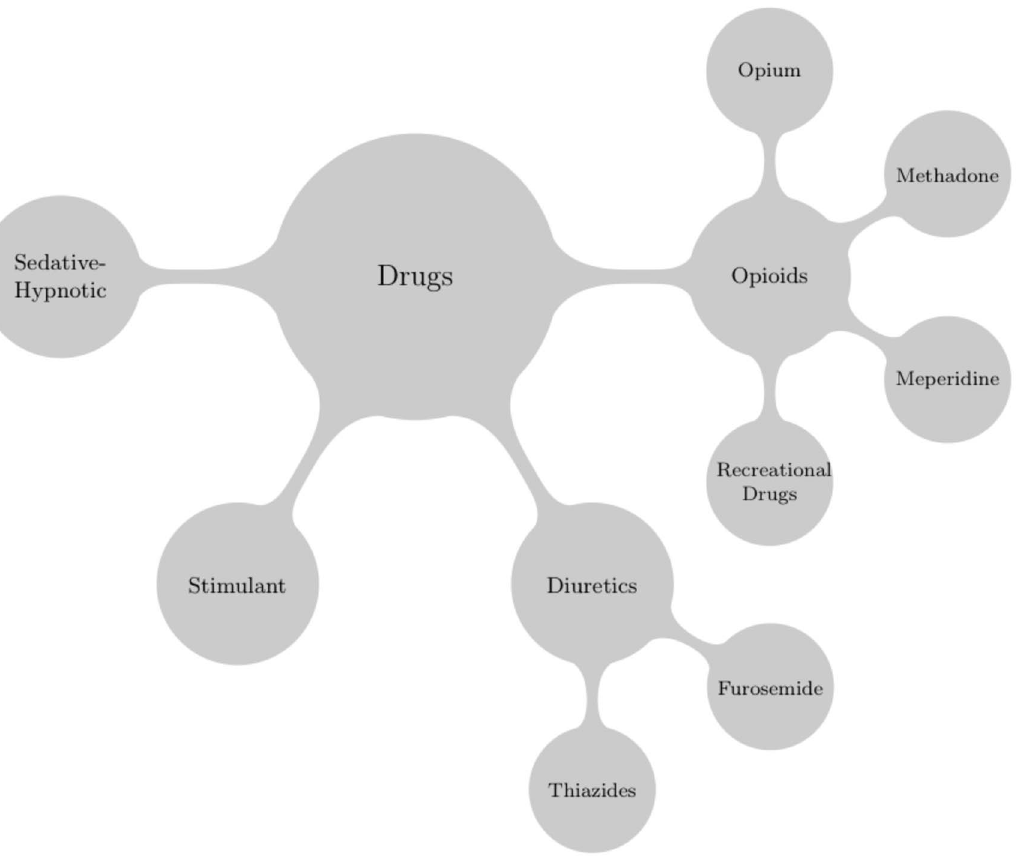
Figure 3. Example WordNet hierarchy. Spreading out from the root concept of drugs are progressive refinements or hyponyms . Counting each path as 1 and starting from the root node, Drugs, one may calculate the path similarity of any two concepts (see text).